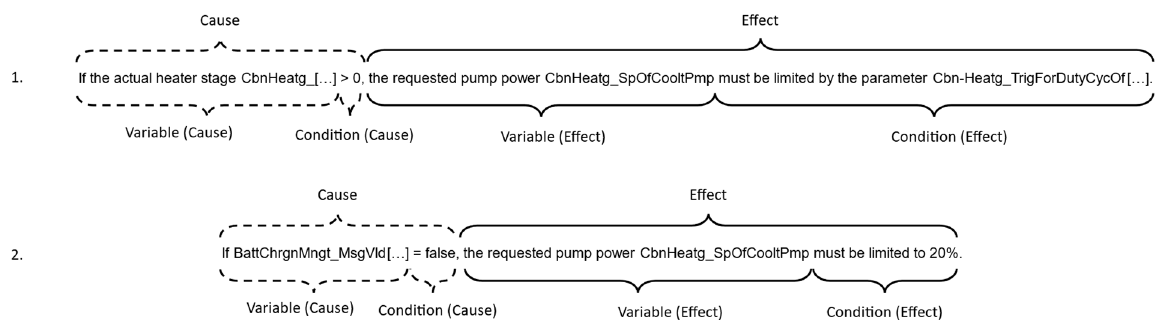
Figure 8. Building blocks for an Alius Subaltern contradiction, consisting of two requirements.